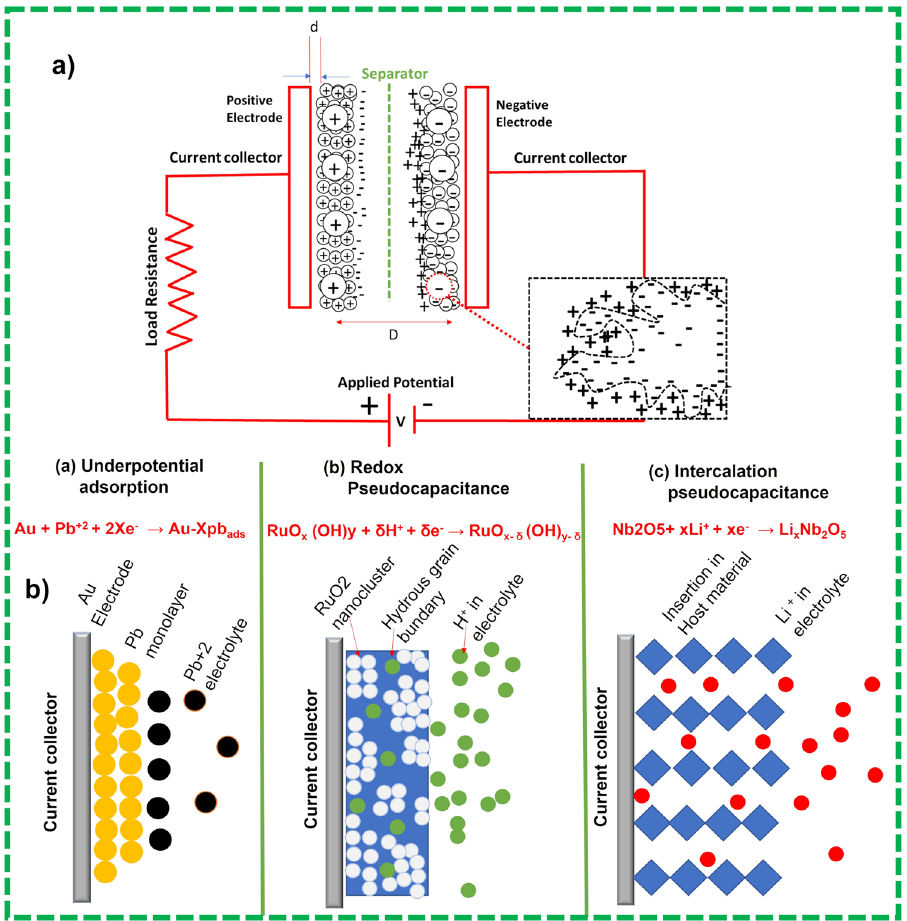
Fig. 8 a Graphical demonstration of EDLCs charge storage mechanism and b various types of redox mechanism in PCs: ( a ) underpotential adsorption, ( b ) redox PCs, ( c ) intercalation PCs. Reprinted with permission from Ref.